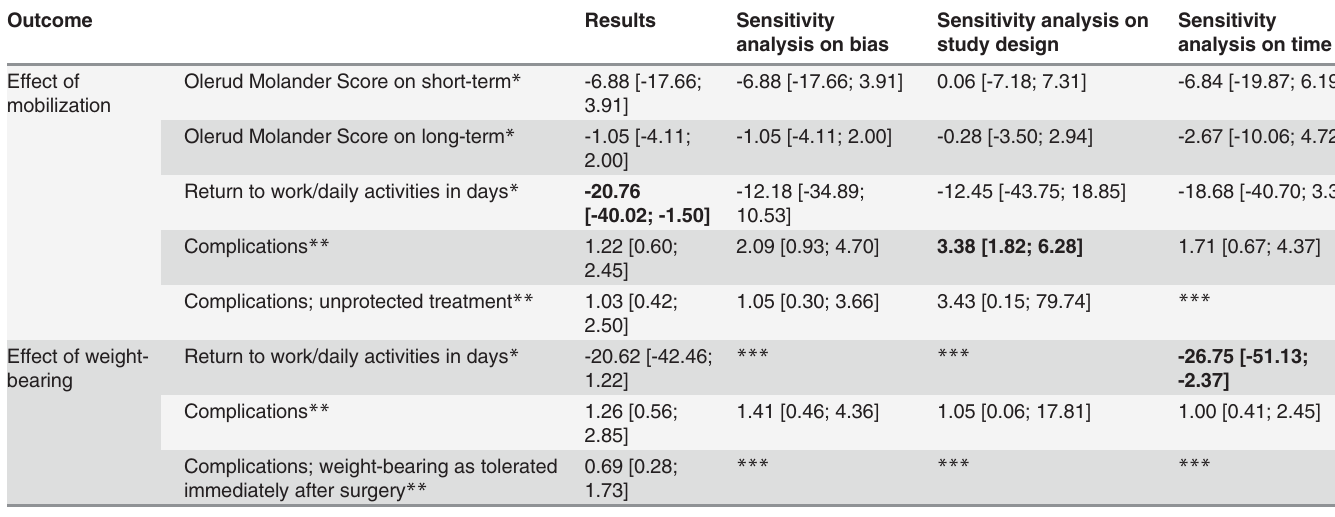
Table 1. Results of sensitivity